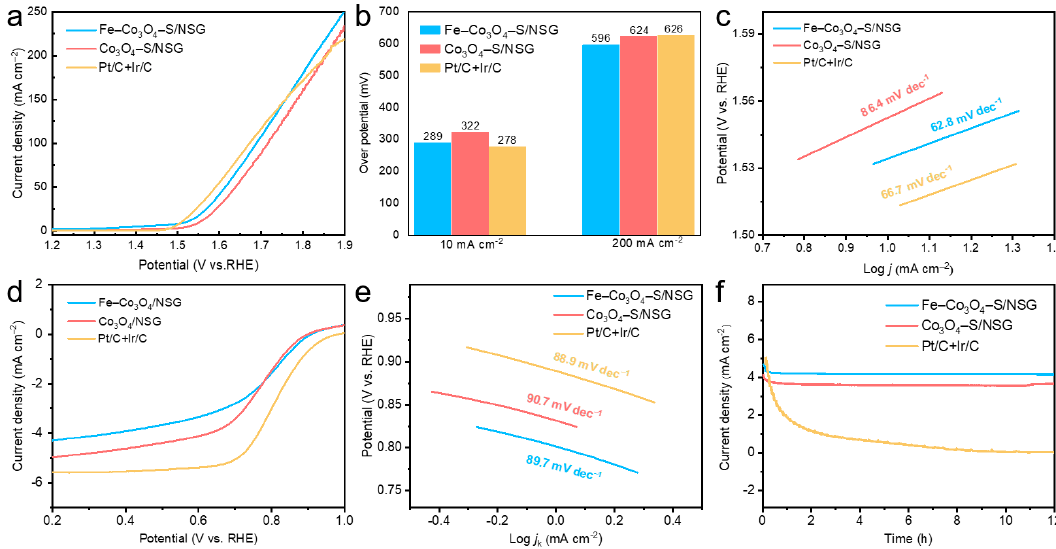
Figure 4. ( a ) OER polarization curves, ( b ) overpotentials at 10 and 200 mA cm –2 current densities, ( c ) corresponding Tafel slopes, ( d ) ORR LSV at a rotation speed of 1600 rpm and ( e ) corresponding Tafel slopes of Co 3 O 4 –S/NSG, Fe–Co 3 O 4 –S/NSG and Pt/C + Ir/C electrocatalysts. ( f ) Chronoamperometric responses of Fe–Co 3 O 4 –S/NSG, Co 3 O 4 –S/NSG and commercial Pt/C + Ir/C at 1.524 V.